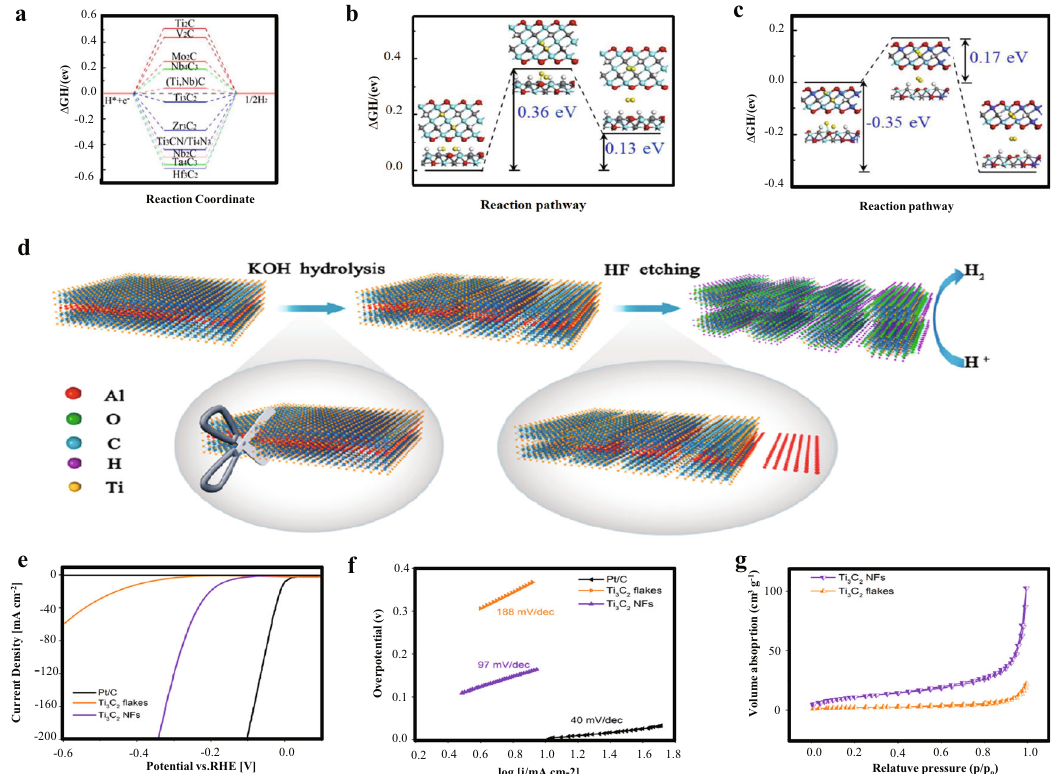
Fig. 9 MXenes-based HER electrocatalysts optimized by nanostructure architecting. a Free energy diagrams for hydrogen evolution at zero potential and pH = 0 on the edges of various MXenes nanoribbons. b Free energy pro fi les for hydrogen formation on the edges of Ti 3 C 2 . c Free energy pro fi les for hydrogen formation on the edges of (Ti, Nb) C MXenes nanoribbons 92 . Copyright 2018, Royal Society of Chemistry. d Schematic diagram for the preparation of Ti 3 C 2 NFs. e LSV and f Tafel slopes of Ti 3 C 2 NFs, Ti 3 C 2 fl akes, and Pt/C electrodes. g N 2